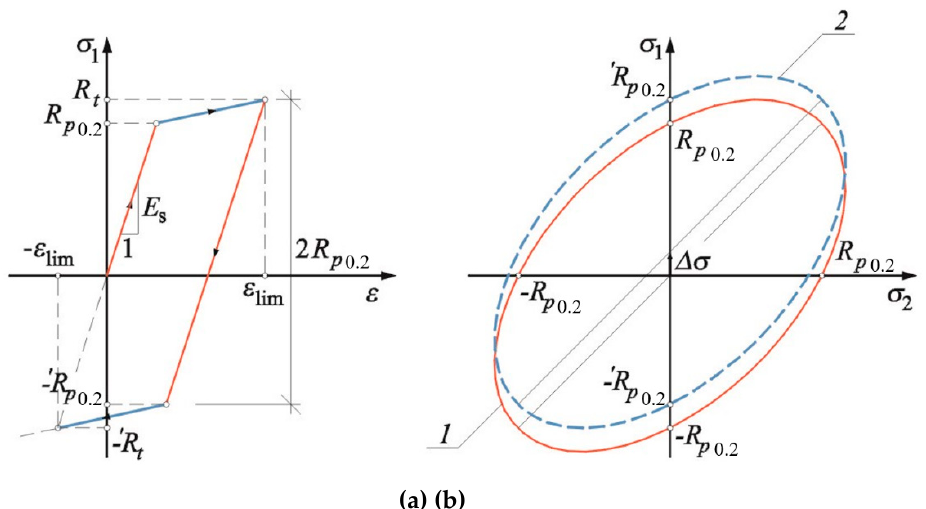
Figure 15 . The Prandtl-Reuss model: ( a ) bilinear relationship σ - ε , ( b ) law of kinematic hardening: 1— initial location of yield surface, 2—subsequent location of yield surface. Table 7. Mechanical parameters of concrete steel used in the numerical model.